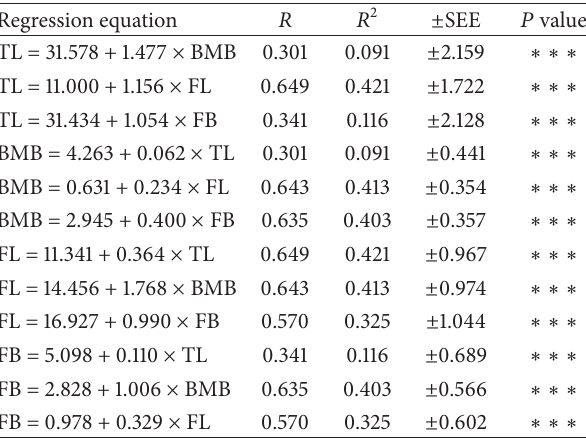
Table 3: Linear regression equations for reconstruction of lower limb dimensions (in cm) in